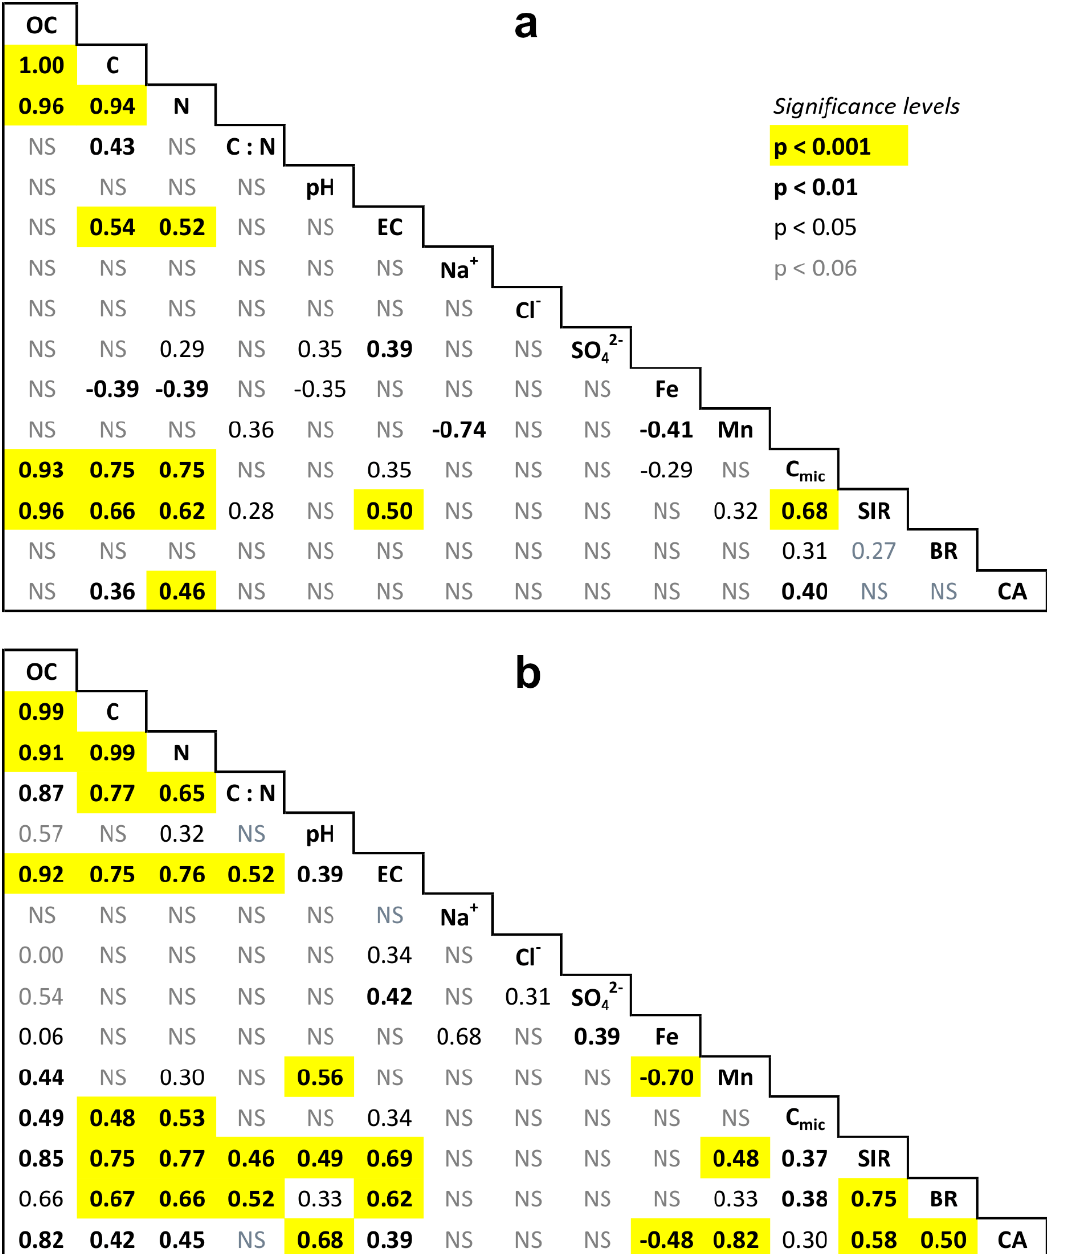
Figure A2. Correlation matrices (Pearson correlation coefficients) of the Box-Cox transformed soil data at ( a ) Bedrich and ( b ) Placek A sites in 2019; OC = organic carbon; C = total carbon; N = total nitrogen; EC = electrical conductivity; C mic = microbial-biomass carbon; SIR = substrate-induced respiration; BR = basal respiration; CA = catalase activity; NS = no significant correlation.